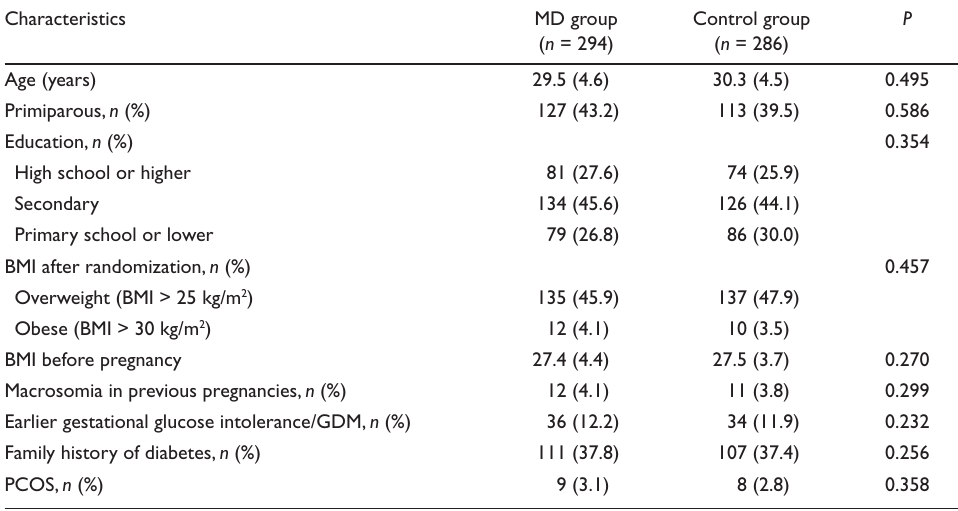
Table 1. Baseline characteristics of the participants